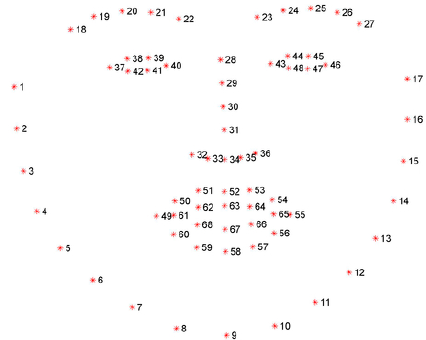
Figure 2. Definition of the 68 facial landmarks. (Image courtesy of [38]).